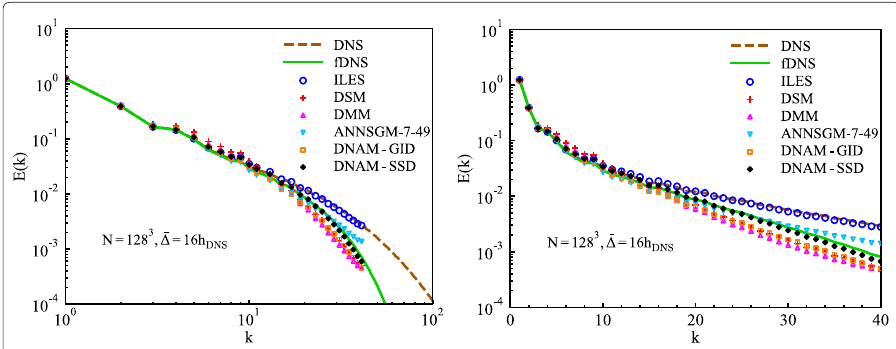
Fig. 5 Velocity spectra in aposteriori study at filter scale 16 h